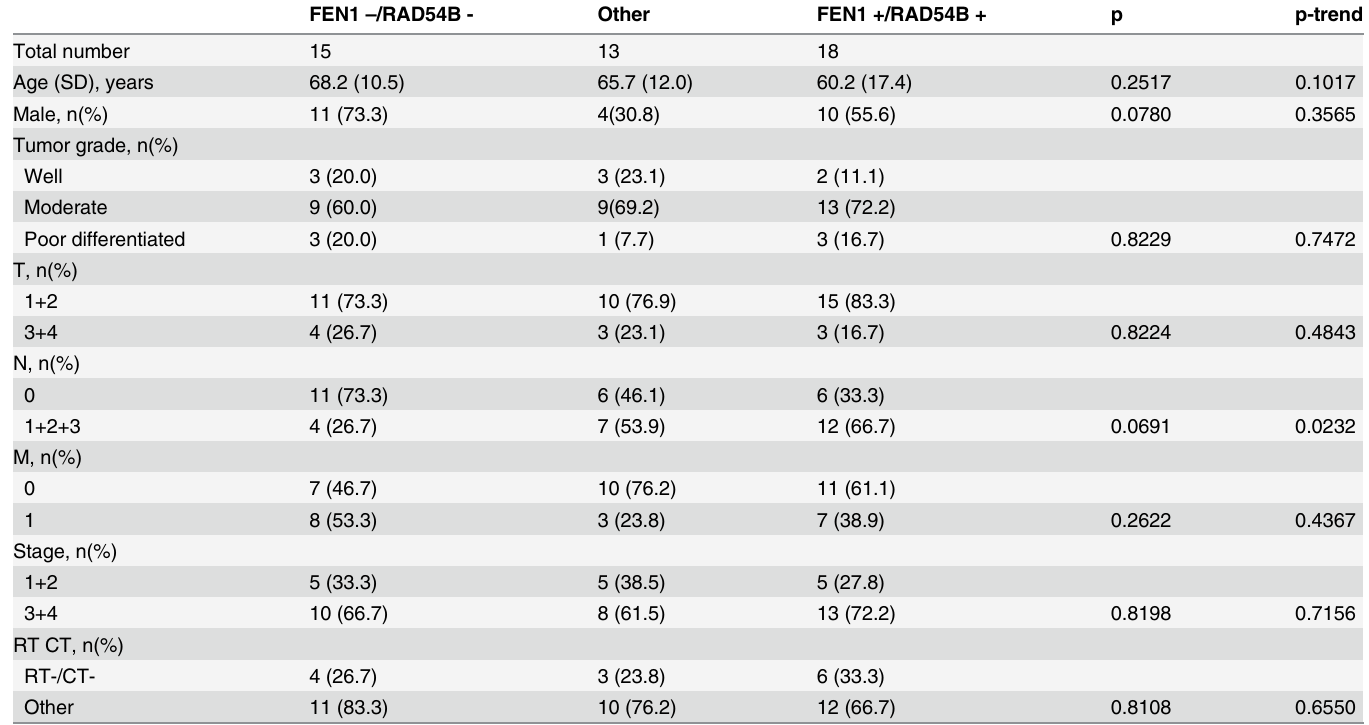
Table 3. Clinical effect of FEN1 and RAD54B in lung cancer death patients.